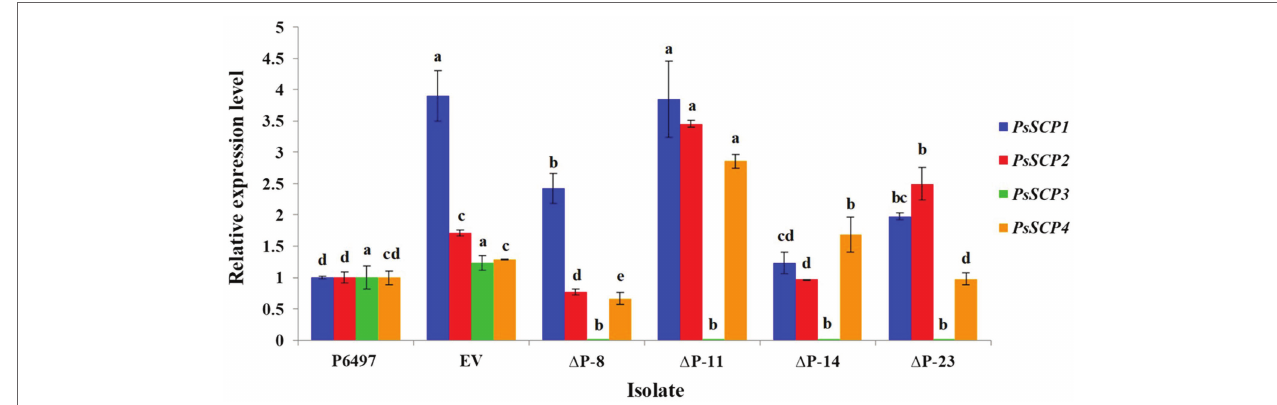
FIGURE 4 | PsSCPs transcript levels in PsPTL ( PsSCP3 ) mutants. The transcript levels of transformants are shown relative to wild-type P6497, which was assigned a value of 1.0. Columns indicate means, and bars show SDs. The same letters above the same color column signify statistically insignificant difference ( p <